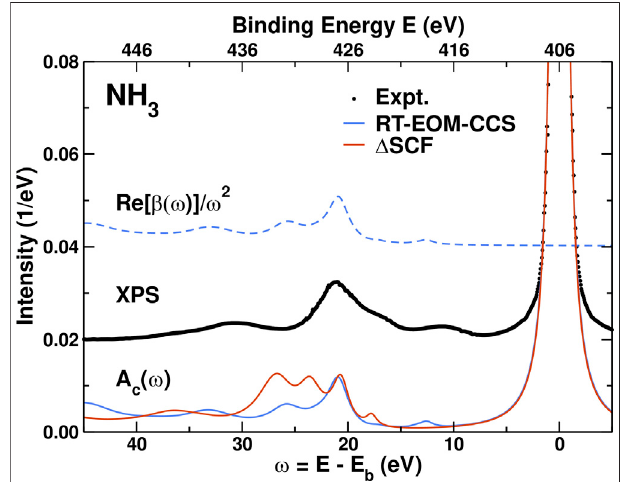
FIGURE 2 | Comparison of the theory errors vs experiment (Karlsen et al., 2002; Buttersack et al., 2019; Viñes et al., 2018; Jolly et al., 1984; Williams,2009)forthecorebindingenergies.Thetheoreticalcalculationswere performed with the 2-4 NL RT-EOM-CCS approximations with the aug- cc-pVDZ basis set. Also shown are results from the second order Dyson equation (DSE2) and the standard GFCCSD and GFCC-i (2, 3) coupled- cluster Green ’ s function methods (Peng and Kowalski, 2016; Peng and Kowalski, 2018a).